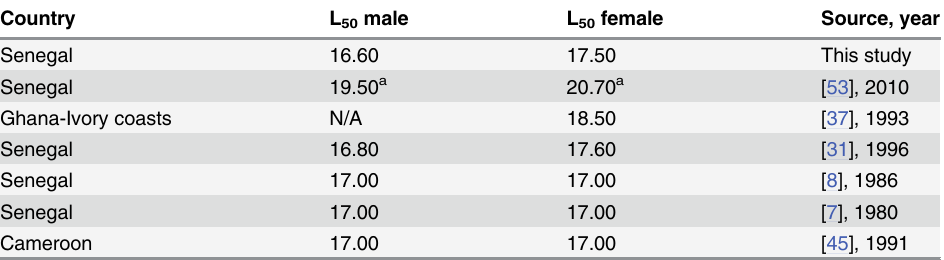
Table 7. L 50 for Sardinella maderensis based on the literature for West African areas. L 50 represents the size at which 50% of individuals in a given population attain maturity. (N/A means not available).